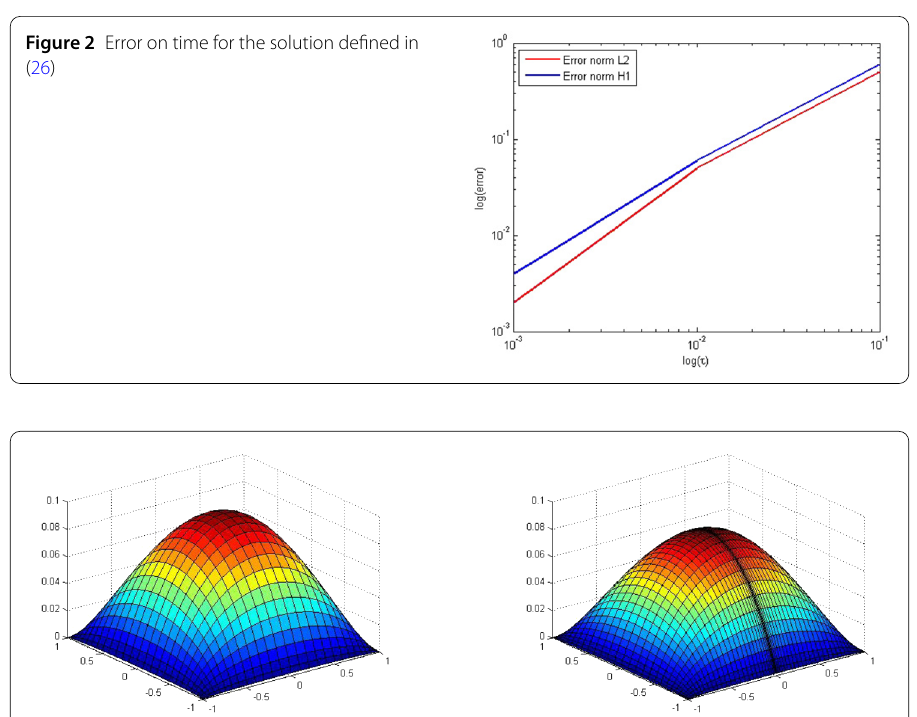
Figure 3 The discrete solution for the data f , ϕ 0 defined in